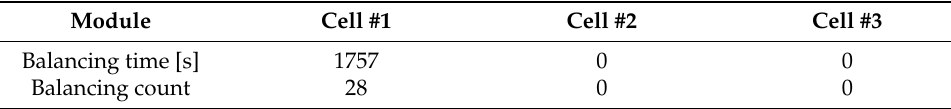
Figure 7. Experimental results from module #3. Table 6. Balancing parameters from module #1.